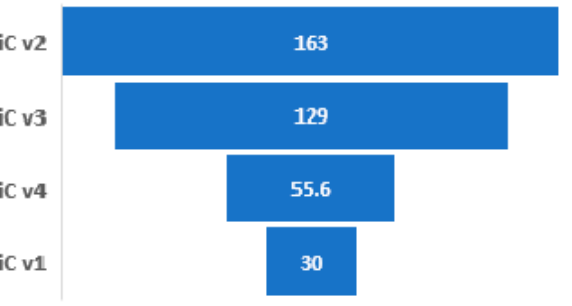
Figure 14. Summary of the gate-source voltage rise-time for selected SiC transistors (evaluated parameter—V grise [ns]).